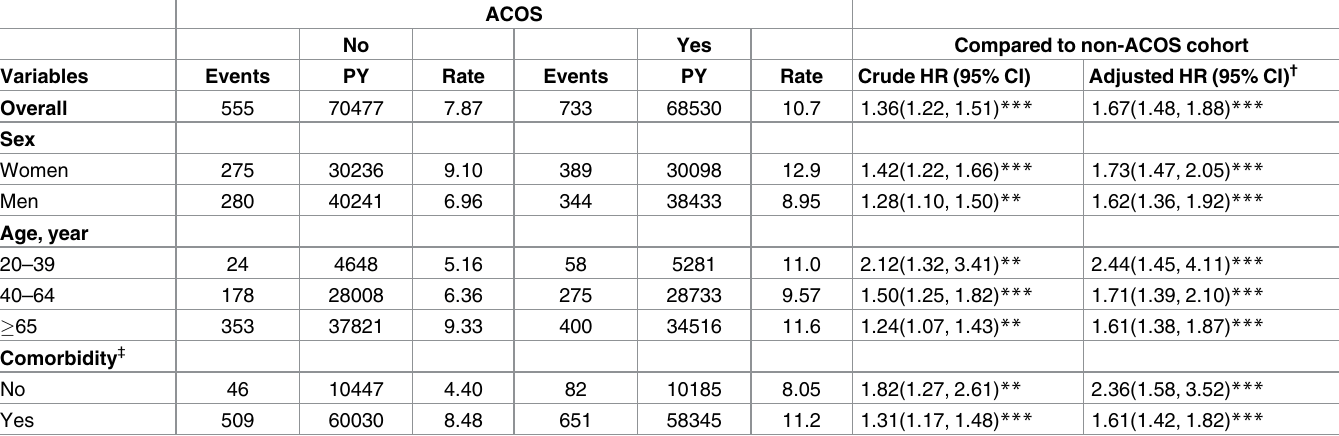
Table 2. Risk of depression between the ACOS and non-ACOS cohorts stratified by sex, age, and comorbidity (no/yes).